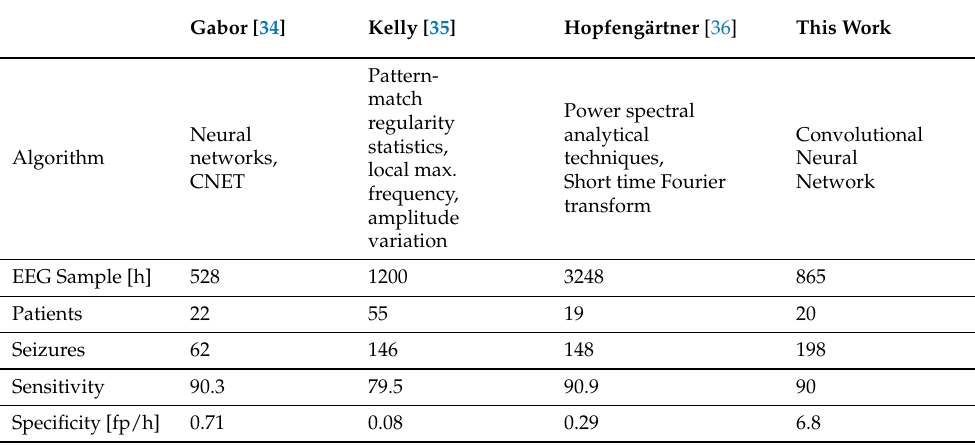
Table 3. Comparison of the performance of different algorithms for seizure detection independent of the hardware requirements, based on those in